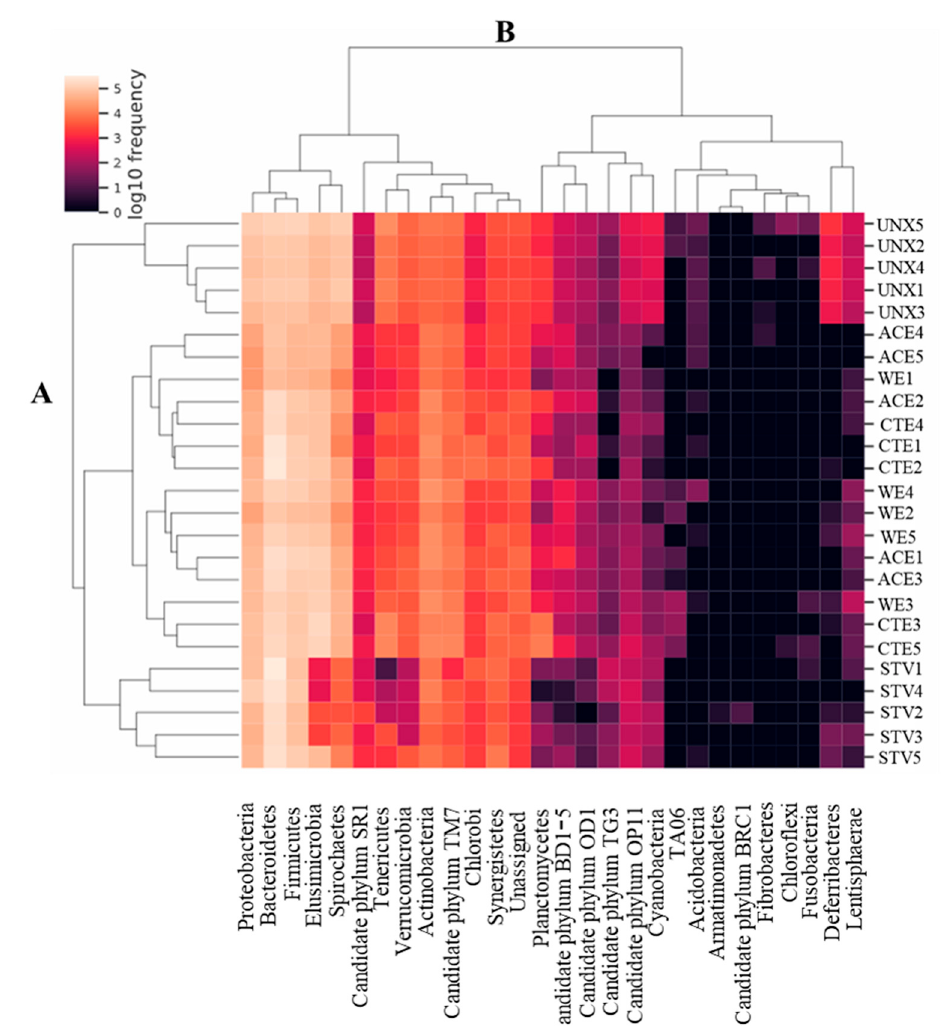
Figure 2. Two-way cluster analysis showing abundance of bacterial phyla per treatment in the hindgut of R. virginicus . Dendrogram A, sample clustering; dendrogram B, phylum clustering; TA06, candidate phylum TA06. The color bar in the top left indicates abundance; light color, high; dark color, low.